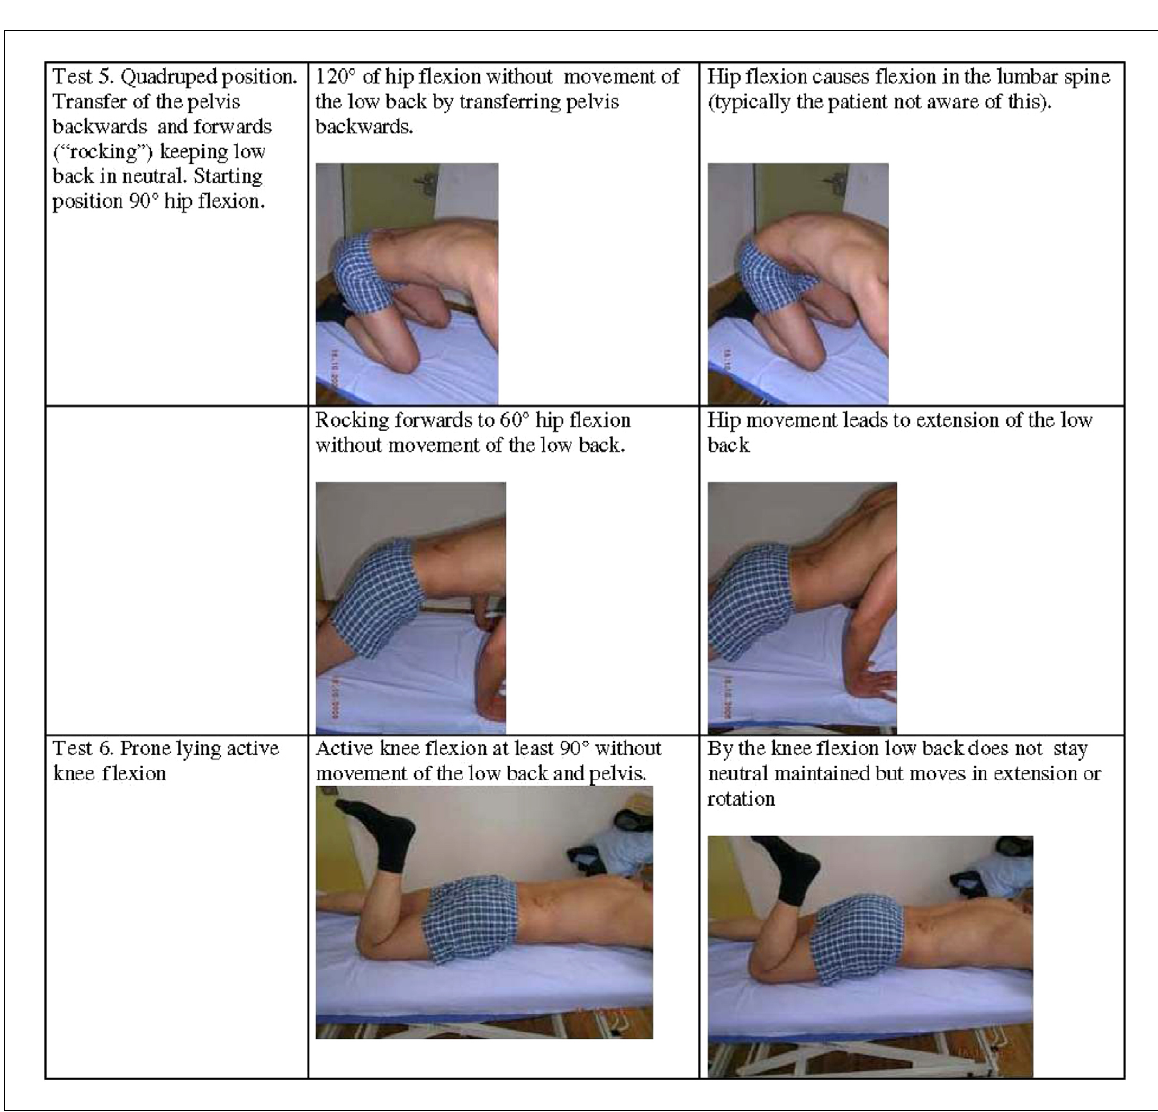
Figure 2. Movement control tests by Hannu Luomajoki (Luomajoki et al., 2008): 1) “Waiters bow”; 2) “Pelvic tilt”; 3) “One leg stance”; 4) “Sitting knee extension”; 5) “Quadruped position”; 6) “Prone lying active knee flexion”